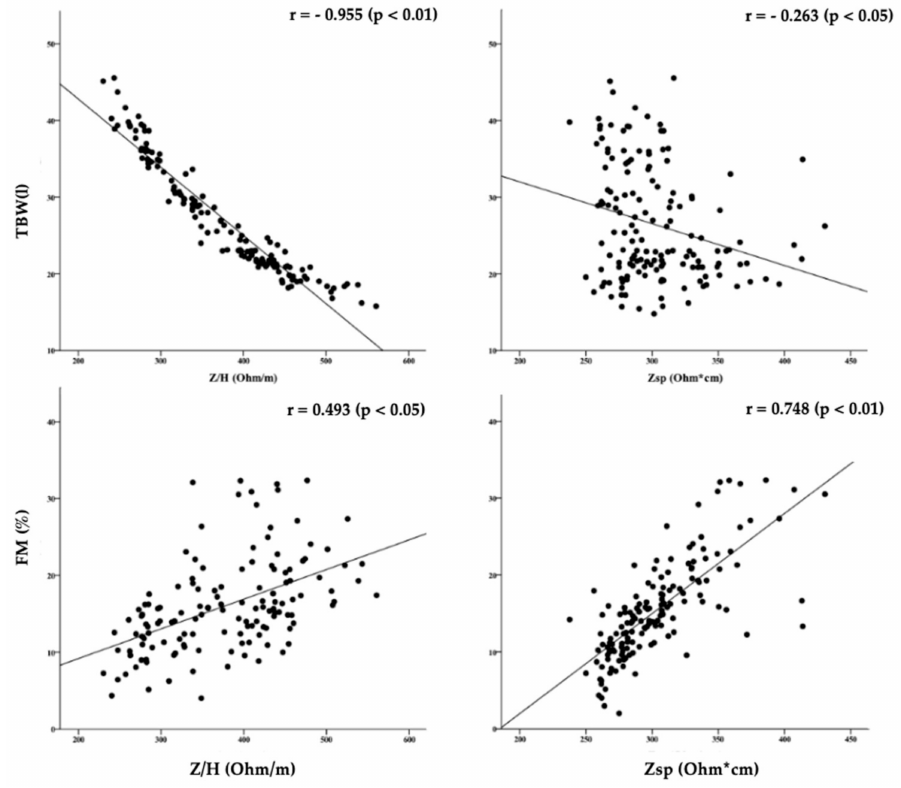
Figure 2. Correlation between classic or specific impedance vectors with TBW (L) or